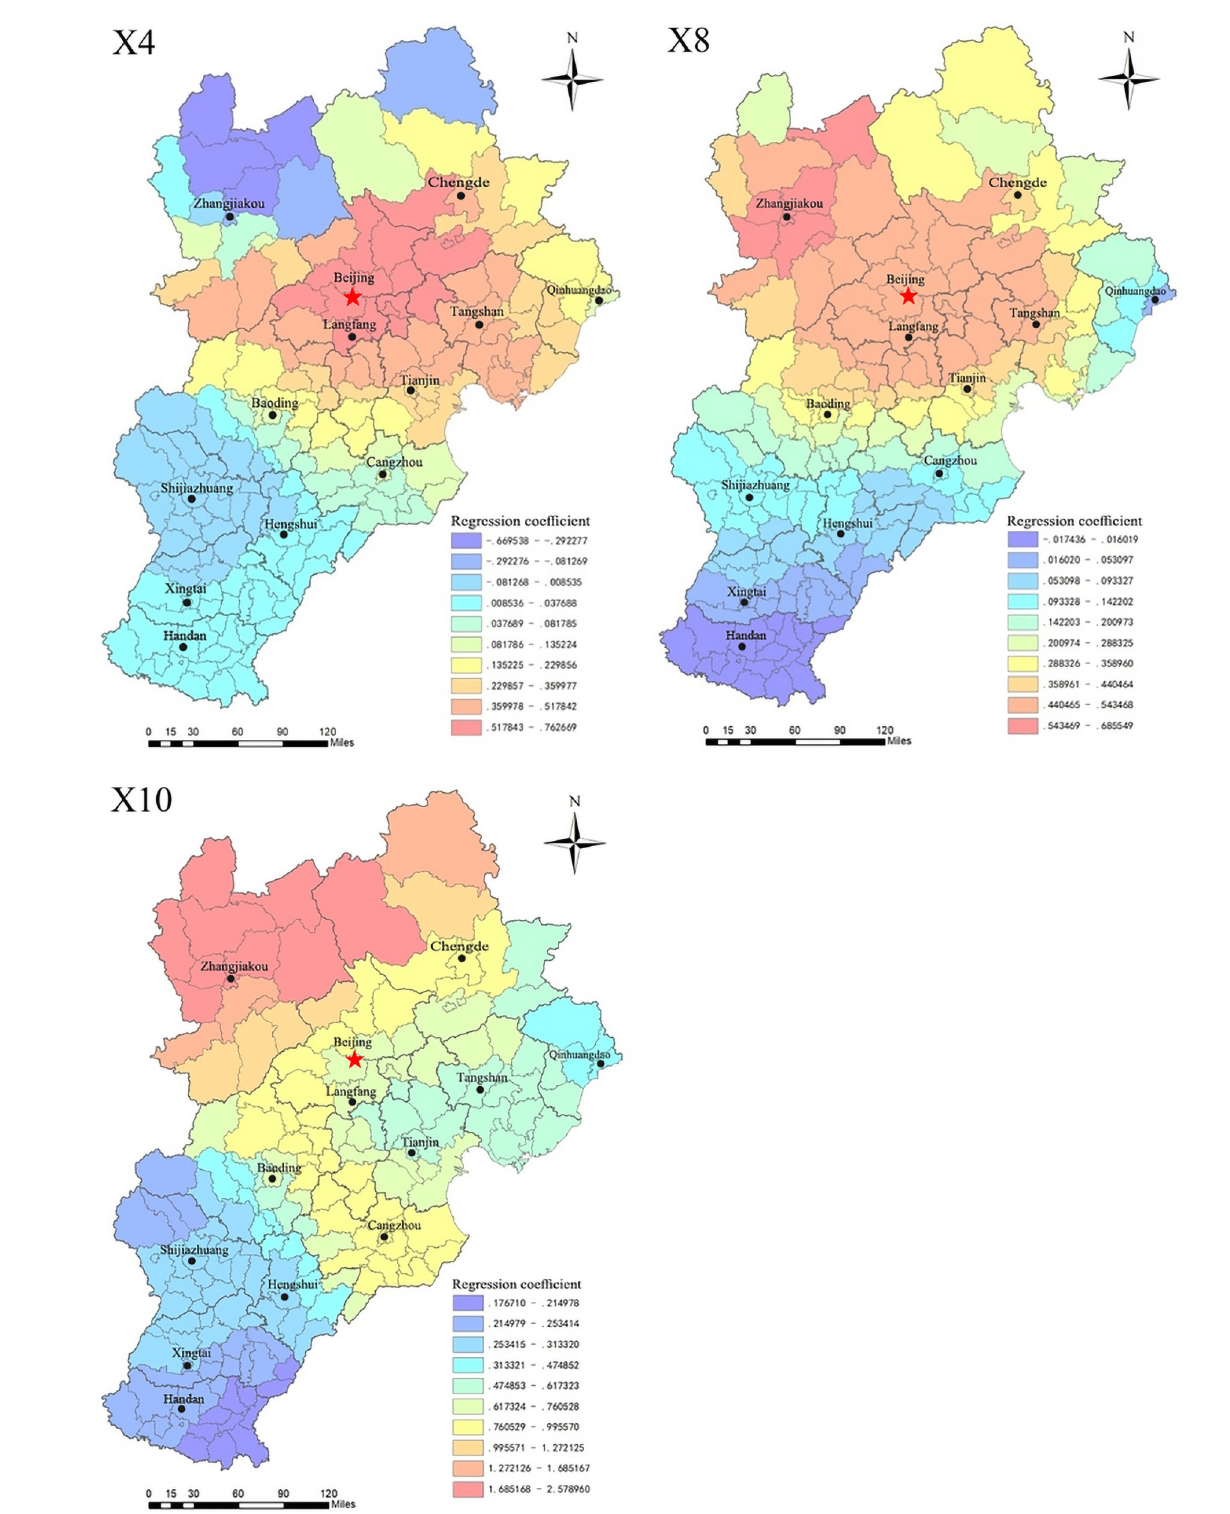
Fig 4. Regression diagram of market indicators for the significant positive driving of residential land prices.